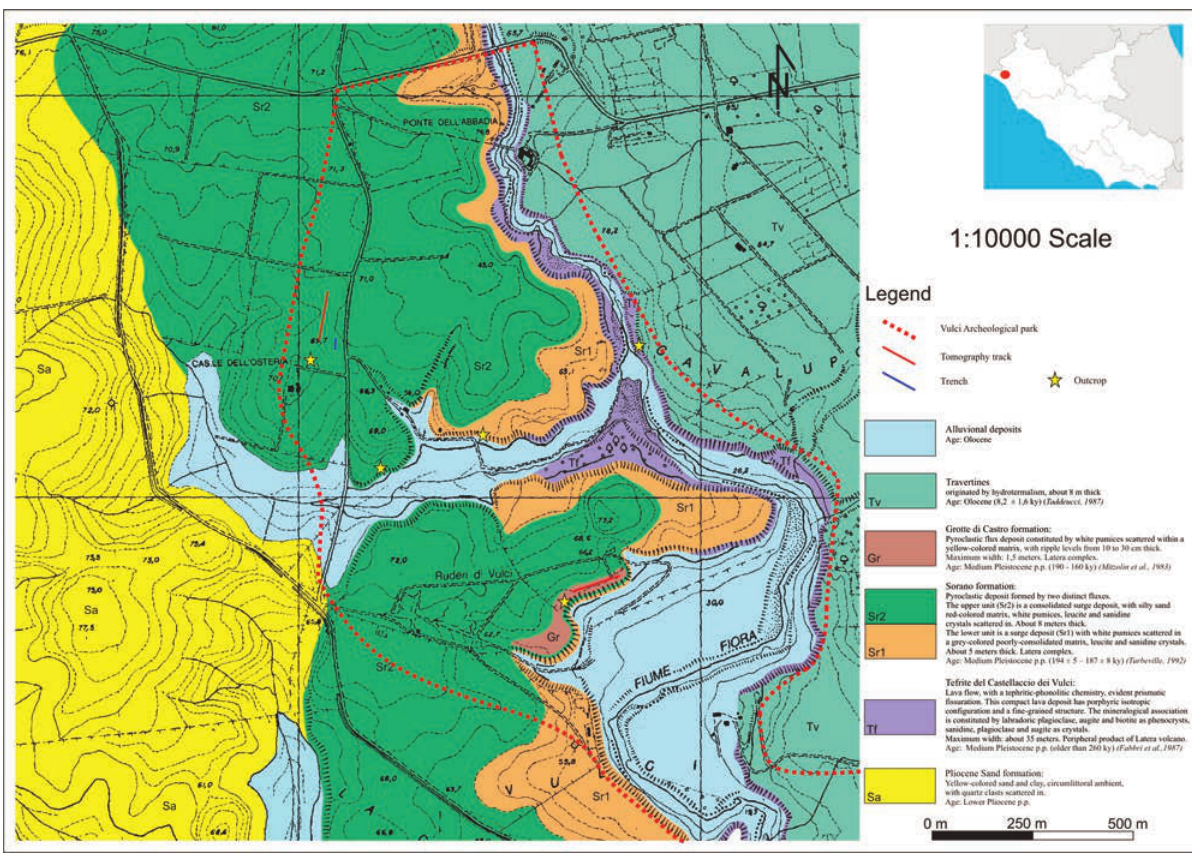
Figure 9. Geological map (1:10000 scale) of the Archeological park of